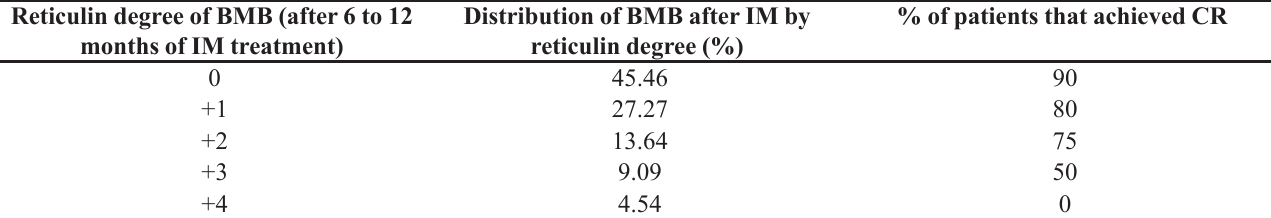
TABLE V - Relationship between Reticulin degree of BMB from CML patients collected after IM treatment and CR Reticulin degree of BMB (after 6 to 12